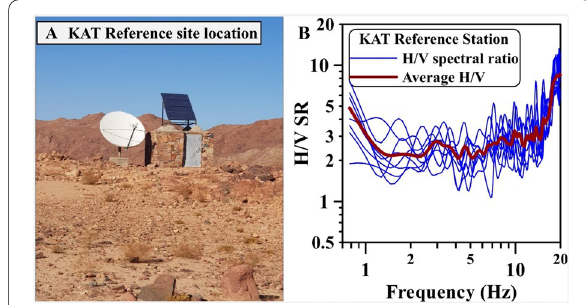
Fig. 4 A Outside view of the location site of the Kathreen (KAT) seismic station; B the horizontal-to-vertical spectral ratio (H/V SR) curve obtained for KAT reference